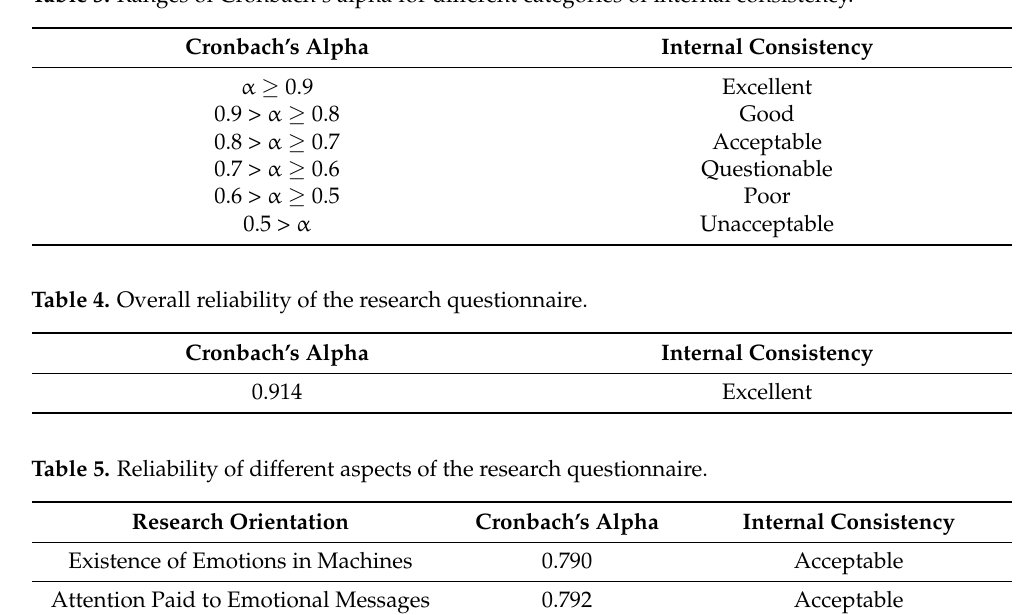
Table 3. Ranges of Cronbach’s alpha for different categories of internal consistency.